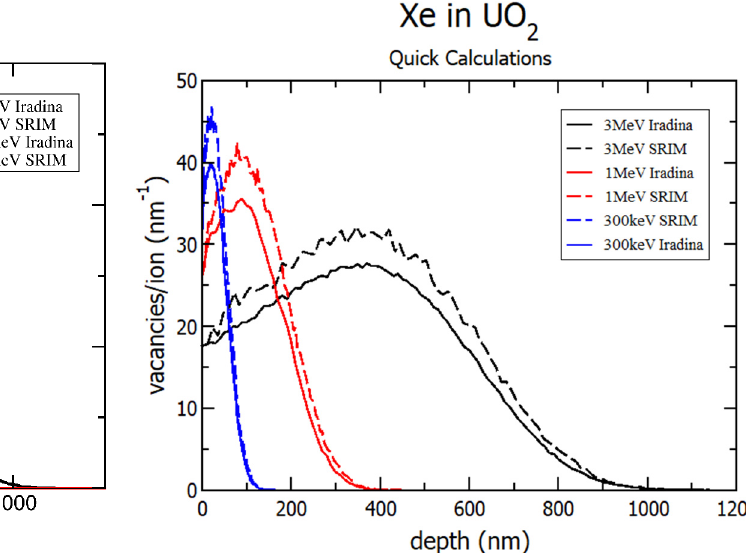
Fig. 2. Damage pro fi le for xenon irradiation in UO 2 estimated with quick calculation. Comparison between Iradina (solid lines) and SRIM (dashed lines).